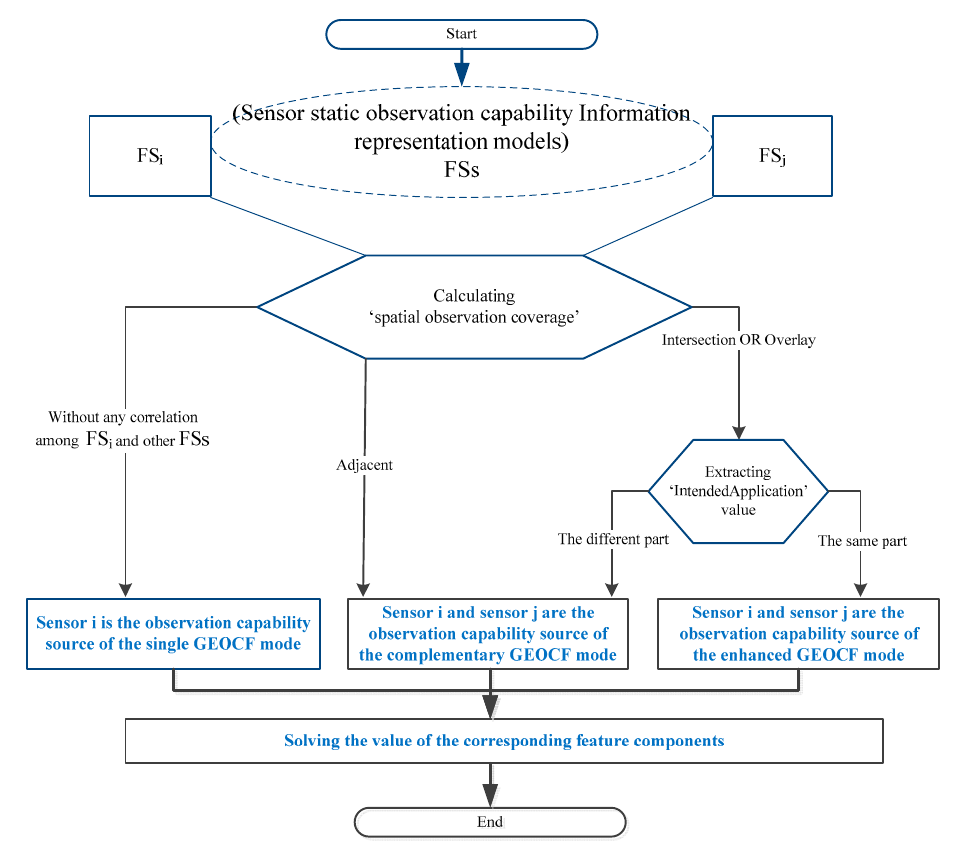
Figure 5. Workflow of the GEOCF union operation.